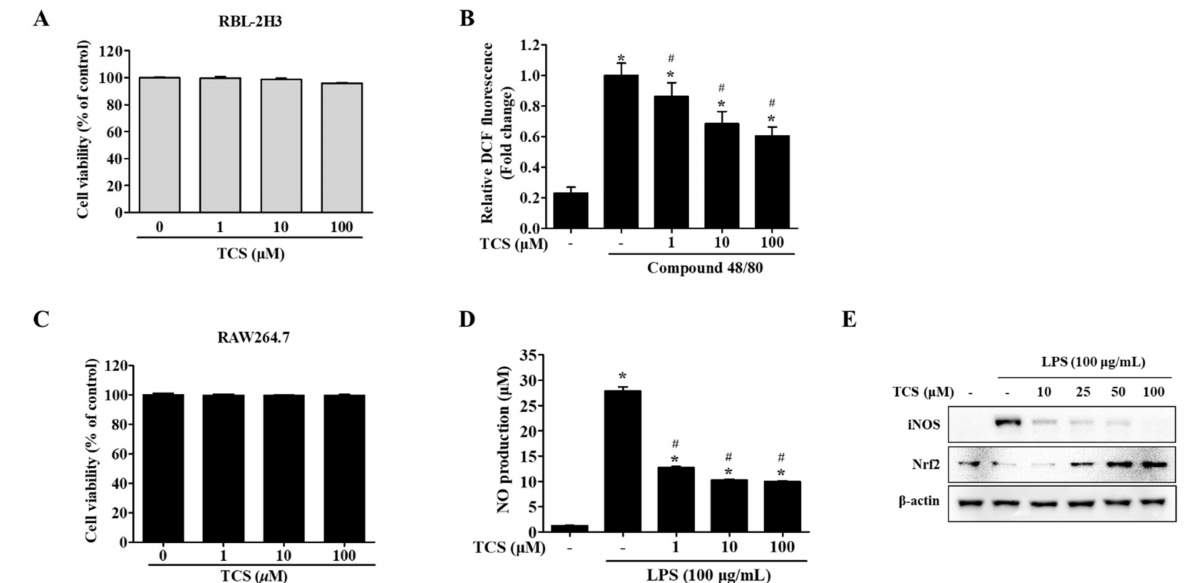
Figure 2. Effects of TCS on reactive oxygen species (ROS) generation ( B ) in RBL-2H3 cells after compound 48/80 stimulation and nitric oxide (NO) production ( D ), inducible nitric oxide synthase (iNOS) and nuclear factor erythroid 2-related factor (Nrf2) expression levels ( E ) in lipopolysaccharide (LPS)-stimulated RAW264.7 cells. ( A ) RBL-2H3 cells were seeded on 96- well plates and treated with TCS (1–100 µ M) for 96 h to perform a water-soluble tetrazolium-1 (WST-1) assay. ( B ) RBL-2H3 cells pretreated with TCS for 24 h in compound 48/80 induced RBL-2H3 cells. The level of 2 (cid:48) ,7 (cid:48) -dichlorodihydrofluorescein (DCF) fluorescence is presented as mean ± SD of three independent experiments. * p < 0.05 vs. control; # p < 0.05 vs. compound 48/80-treated cells. ( C ) RAW264.7 cells were treated with TCS for 24 h for cell viability assay. ( D ) RAW264.7 cells were pretreated with TCS for 3 h, followed by incubation with or without LPS (100 µ g/mL) for 24 h. Data are expressed as mean ± SD of three independent experiments. * p < 0.05 vs. control; # p < 0.05 vs. LPS-treated cells. ( E ) RAW264.7 cells were pretreated with varying amounts of TCS (10, 25, 50, and 100 µ M) for 4 h, then treated with LPS (100 µ g/mL) for 24 h and subjected to Western blotting analysis with iNOS, Nrf2, and β